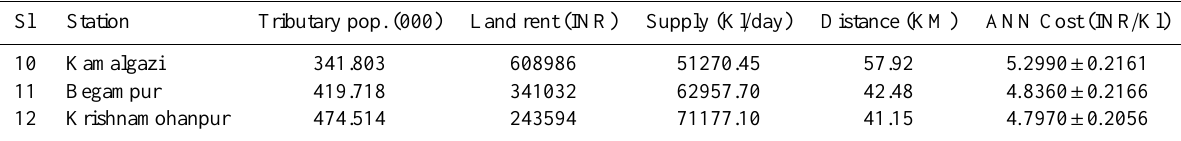
Table 4. ANN Results of the DRWW Network.